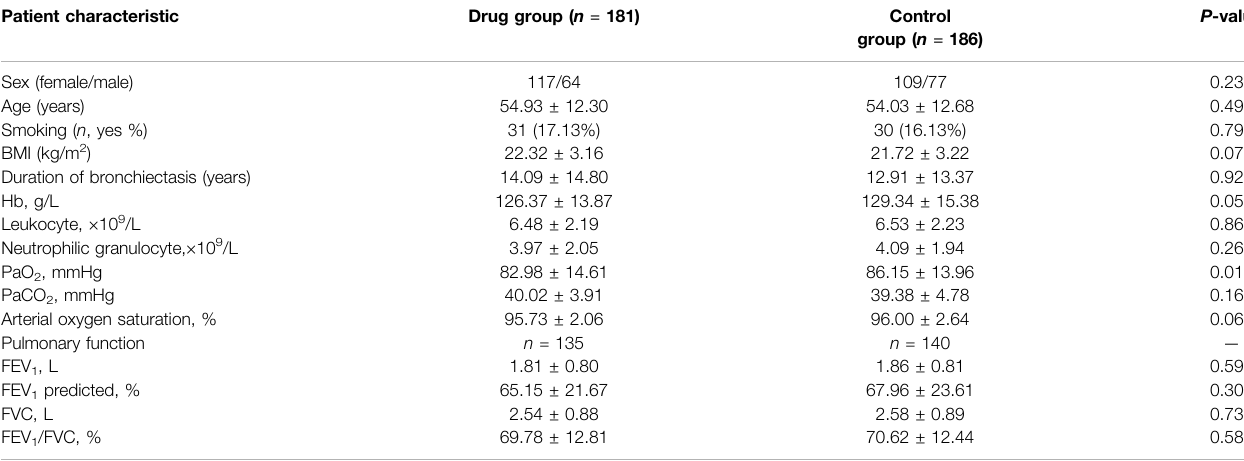
TABLE 1 | Baseline data and clinical characteristics of subjects with non-CF bronchiectasis during exacerbation.